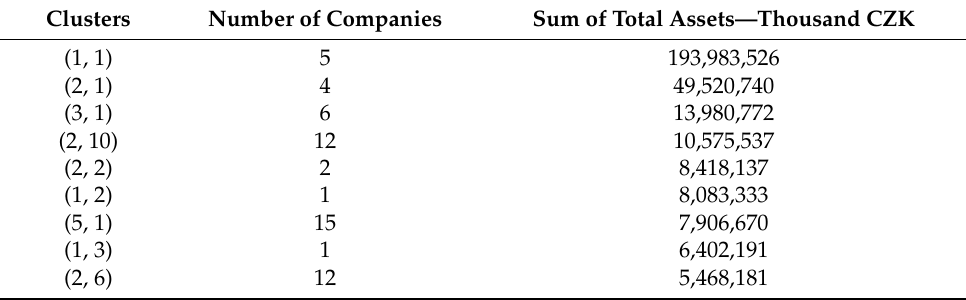
Table 8. Table of ten clusters with the highest sum of assets for the year 2015. Clusters Number of Companies Sum of Total Assets—Thousand